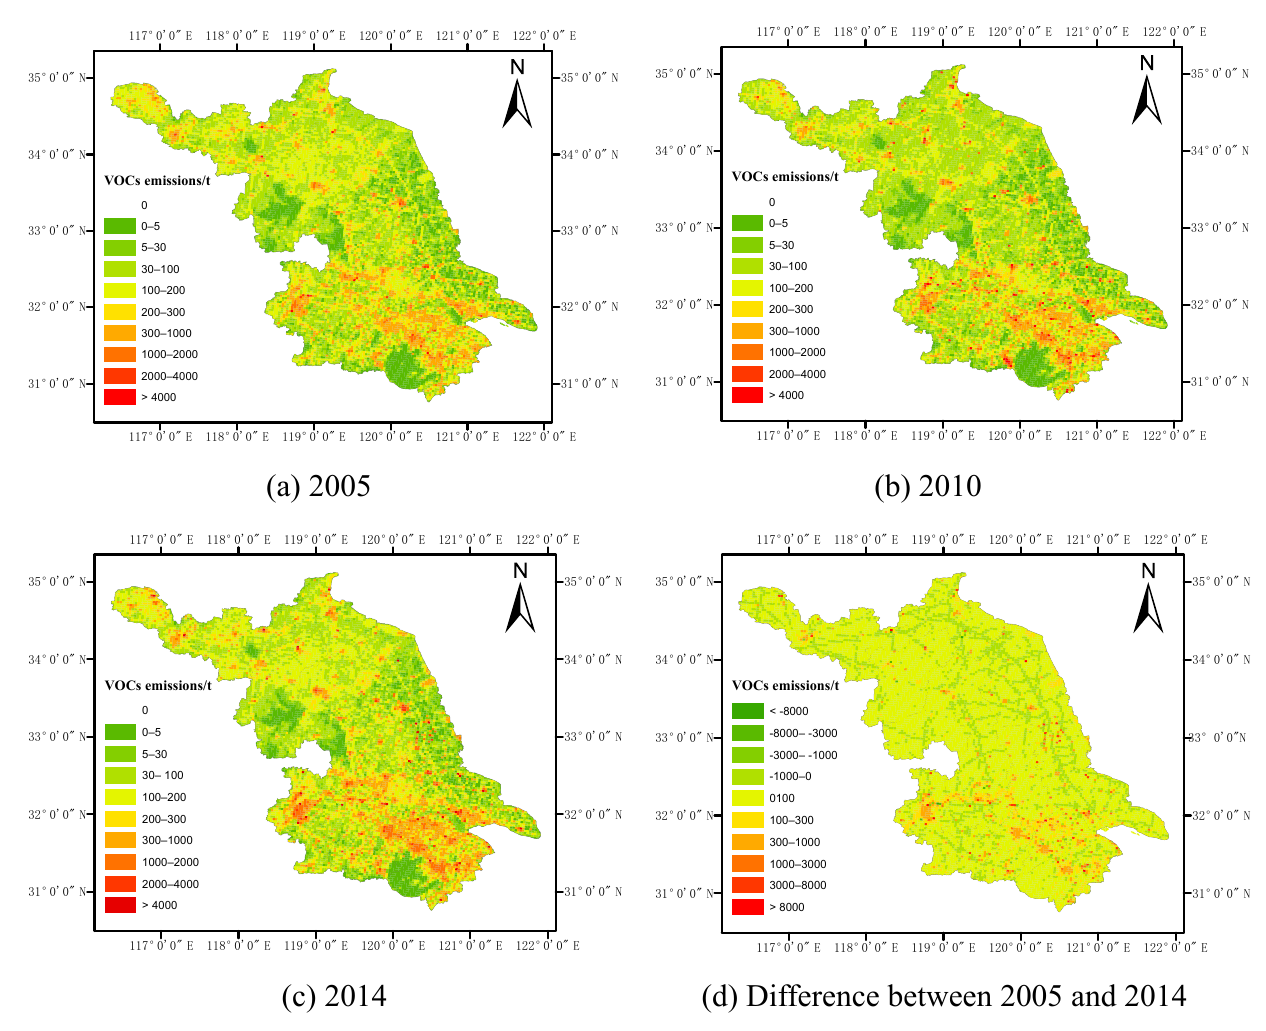
Figure 2. Spatial distribution of Jiangsu’s anthropogenic NMVOC emissions (3 × 3km) for 2005 (a) , 2010 (b) and 2014 (c) , and the differ- ences between 2005 and 2014 (2005 data subtracted from 2014 data; d